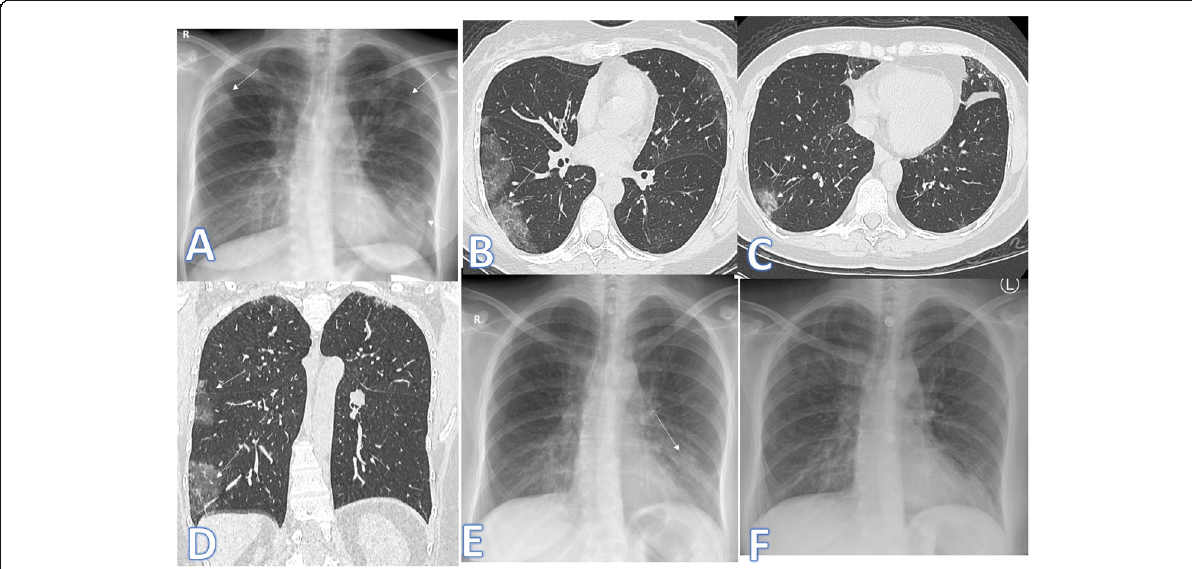
Fig. 15 A 38-year-old female patient with fever and cough. Initial X-ray ( a ) showed bilateral small air space opacities (arrows). On CT chest, there was bilateral peripheral GGO (arrows). X-ray done 1 year before ( e ), and there was a left lower lobe air space opacity which was resolved on X-ray ( f ) 6 months later (fleeting). The diagnosis was Loffler ’ s